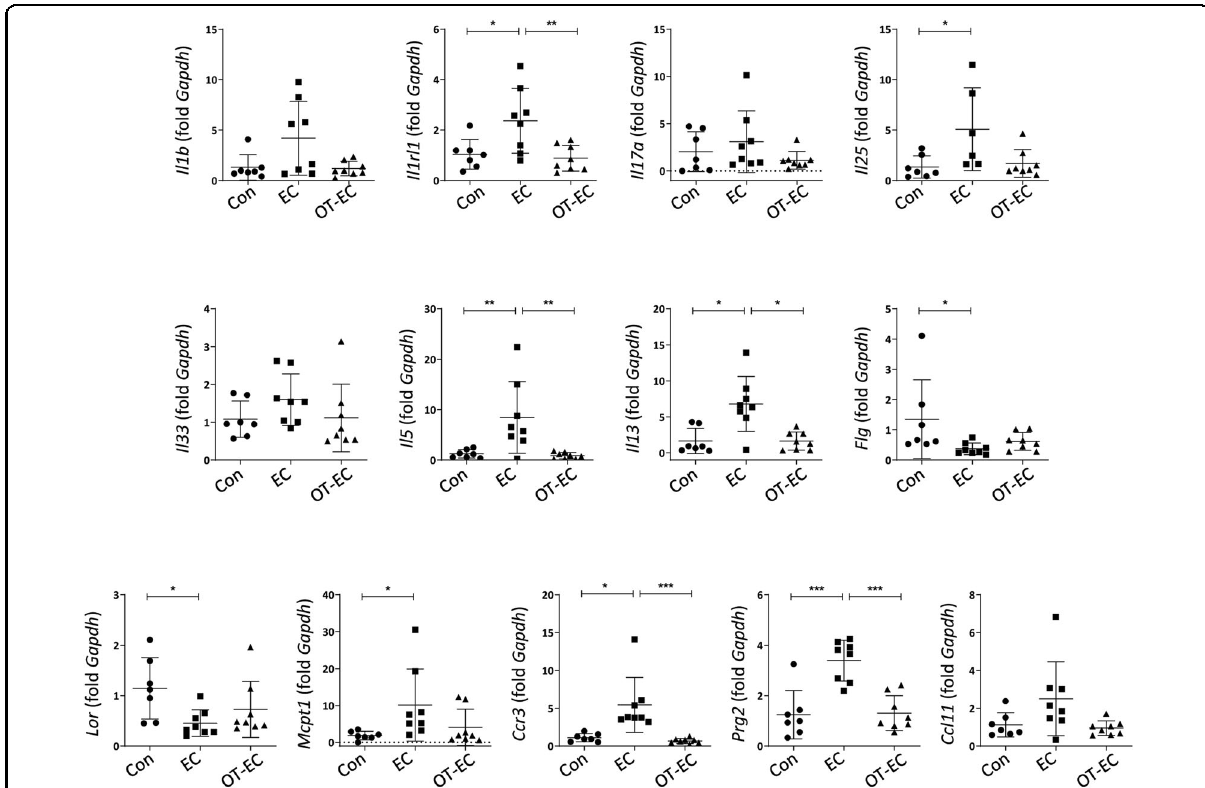
Fig. 2 Skin expression of allergic in fl ammatory markers of EC-challenged mice was inhibited by oral tolerance induction. mRNA expression of Il1b, Il1rl1 , Il17a , Il25 , Il33 , Il5 , Il13 , Flg , Lor , Mcpt1 , Ccr3 , Prg2 , and Ccl11 in the skin of the indicated mice. All data are representative of two independent experiments. The graphs show the mean ± SD values. * P < 0.05, ** P < 0.01, *** P < 0.001 (one-way ANOVA for Il1rl1 , Il5 , Flg , and Prg2